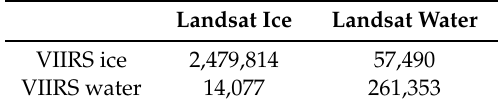
Table 4. VIIRS/Landsat ice and water classification results.